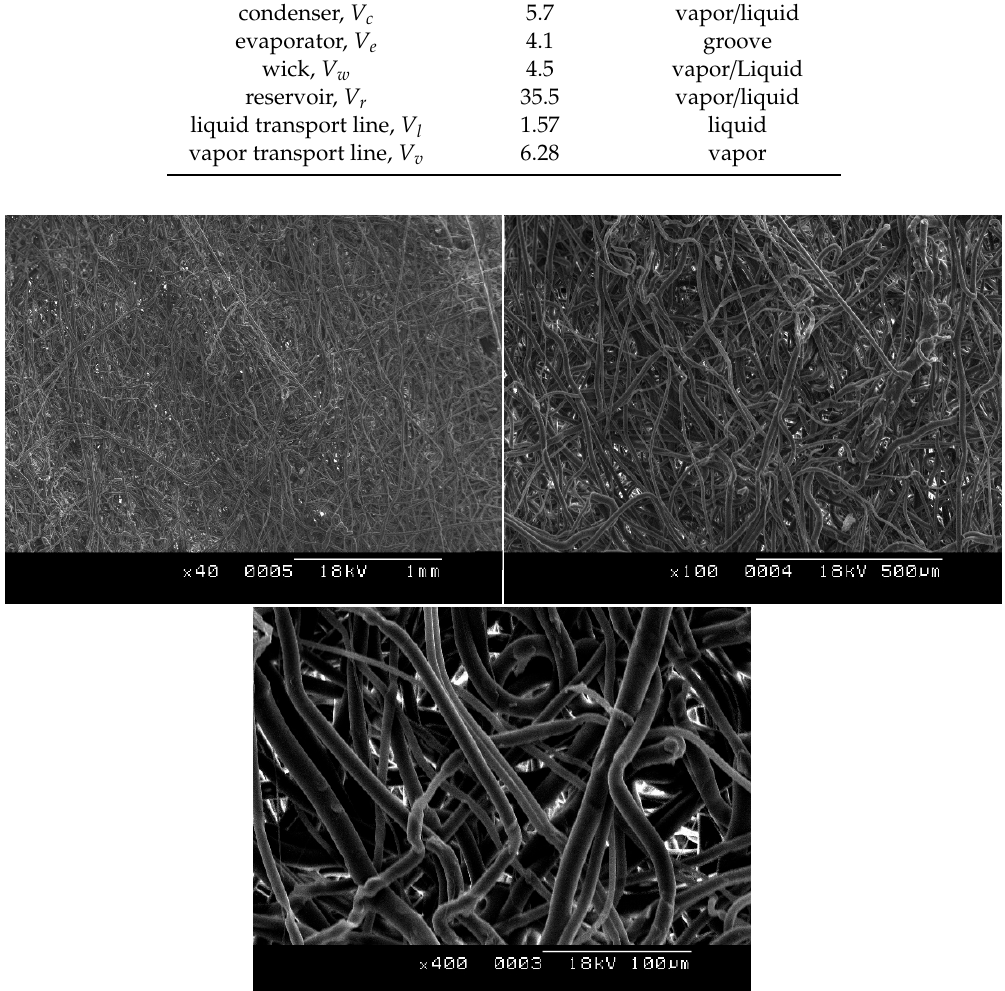
Figure 2. Scanning electron microscope (SEM) images of the polypropylene fiber wick structure with pore size of 0.5 μ m: ( a ) normal magnification: of 40×; ( b ) normal magnification: of 100×; ( c ) normal magnification: of 400×.